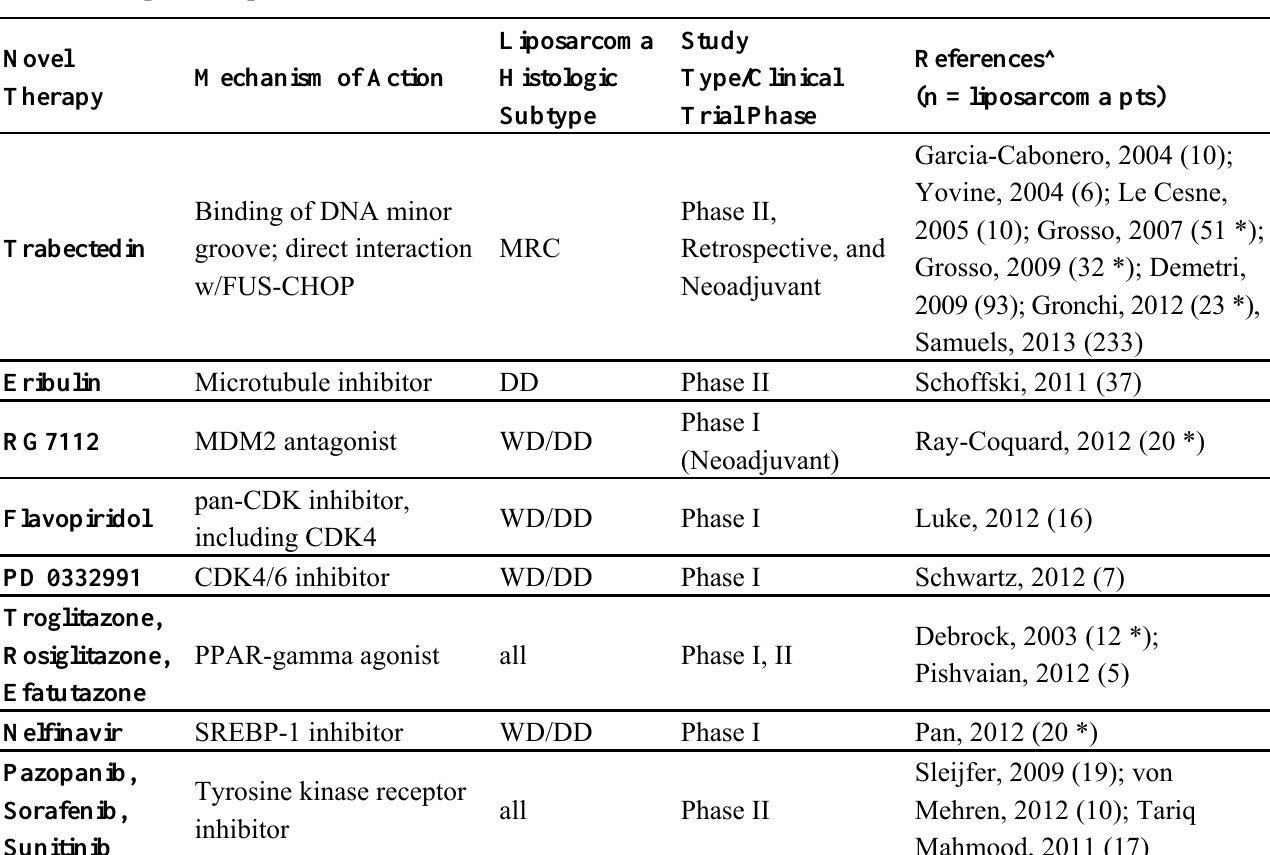
Table 2. Overview of reported human studies and clinical trials for novel systemic therapies in